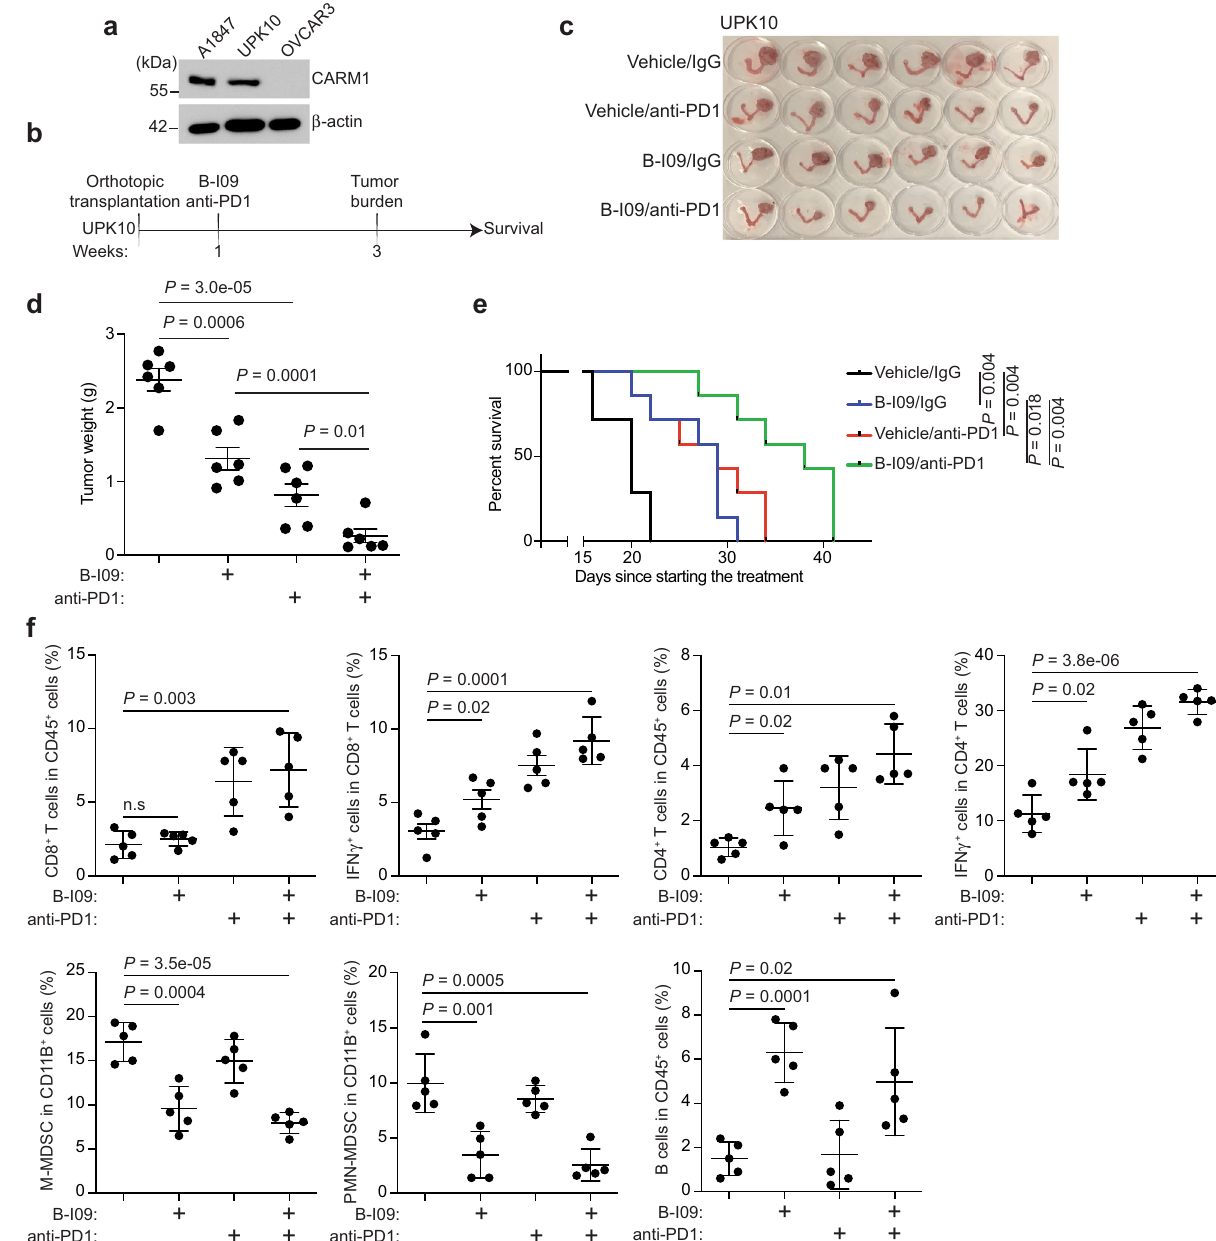
Fig. 7 B-I09 synergizes with immune checkpoint blockade. a Expression of CARM1 and a loading control β -actin in UPK10, A1847, and OVCAR3 cells determined by immunoblot. Immunoblots are representative of three biologically independent experiments with similar results. b Schematic of the experimental design for UPK10 syngeneic immunocompetent mouse model. c Mice bearing orthotopic tumors were randomized into four indicated treatment groups. Reproductive tracts with tumors from the indicated treatment groups were dissected at the end of treatment ( n = 6 mice per group). d The weights of tumors dissected from the indicated groups were measured as a surrogate for tumor burden. Data represent mean ± SEM . P values were calculated using two-tailed t test. Statistical co-ef fi ciency of drug interaction (CDI) analysis revealed that the CDI for the combination is 0.59 (<1) 38 , which indicates synergy between B-I09 and anti-PD1 combination. e After stopping the treatment, the mice were followed for survival. Kaplan – Meier survival curves for the indicated groups ( n = 7 per group). f Immune cell in fi ltration in the tumors dissected from the indicated treatment groups were analyzed by fl ow cytometry. n = 5 mice per group. P values were calculated by two-sided log-rank